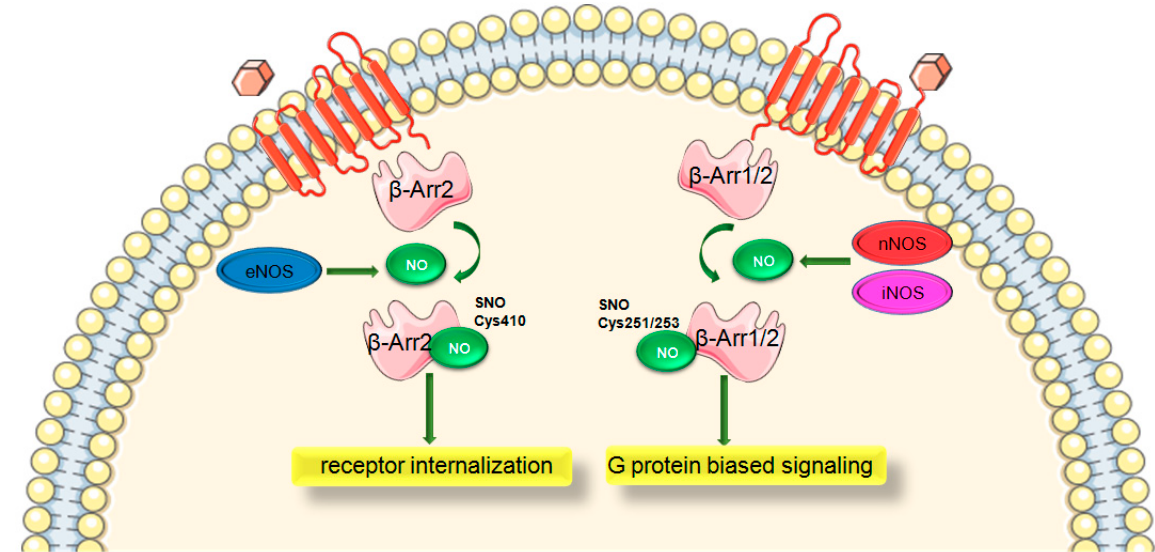
Figure 3. Differential regulation of β -arrestins via S-nitrosylation. β -Arr, β -arrestin; NO, nitric oxide; eNOS, endothelial nitric oxide synthase; nNOS, neuronal nitric oxide synthase; iNOS, inhibitory nitric oxide synthase. Green arrow is used to indicate a stimulatory mechanism involved.